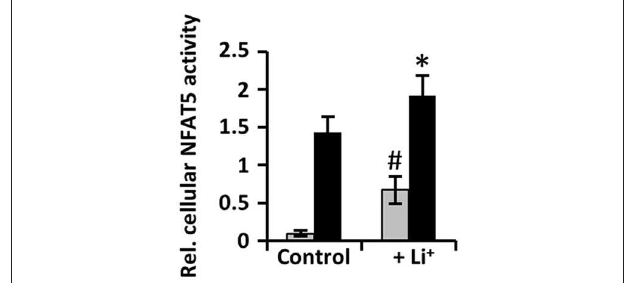
FIGURE 1 | Short-term exposure to lithium increases cellular NFAT5 activity. HEK 293 cells stably transfected with a reporter construct in which the SEAP gene is under control of two TonE sites were incubated for 24h in isosmotic ( ; 300 mosm/kg H 2 O) or hyperosmotic ( (cid:4) ; 500 mosm/kg H 2 O) medium and exposed to 10mM Li 2 SO 4 or 10mM Na 2 SO 4 (as control). After 24h, SEAP activity was measured as described in Methods. Data are means ± SEM for n = 6 ; * P < 0.05 vs. hyperosmotic control; # P < 0.05 vs. isosmotic